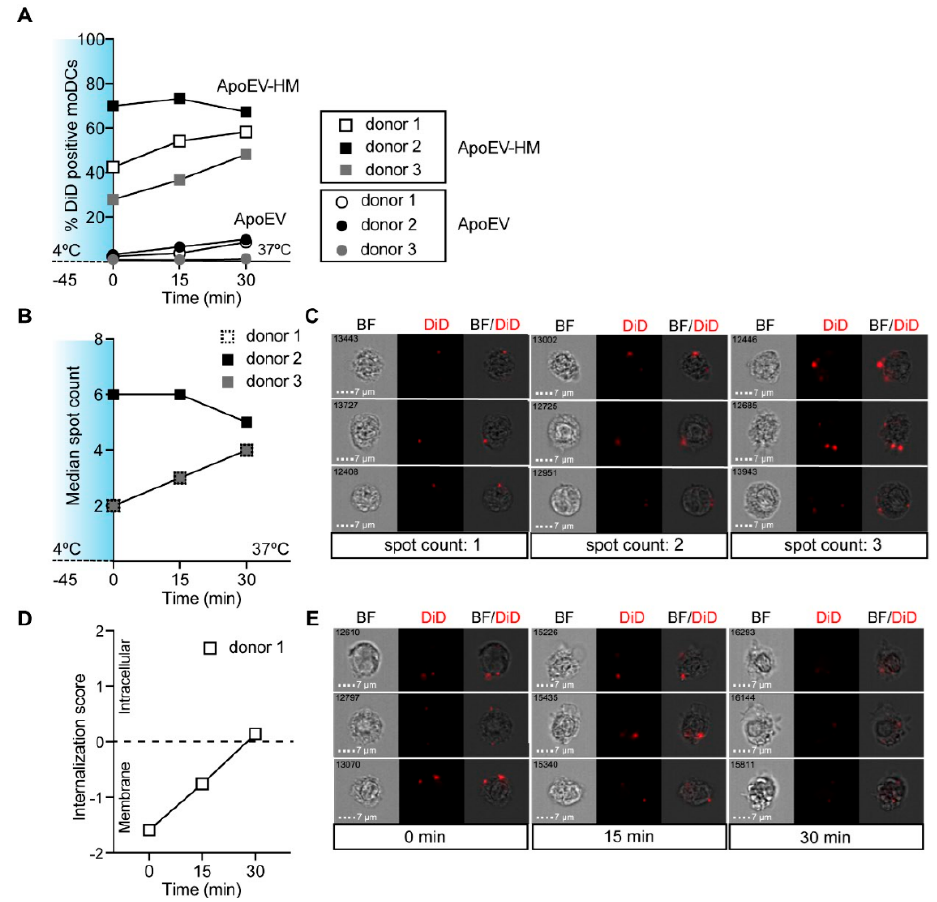
Figure 3. Glycan modified ApoEVs (ApoEVs-HM) are internalized by moDCs. ( A ) MoDCs (white = donor 1, black = donor 2, grey = donor 3) were loaded with DiD-labeled ApoEVs and ApoEVs-HM for 45 min at 4 °C, washed, and incubated at 37 °C for the indicated times. MoDCs were analyzed using imaging flow cytometry. ( B ) Time course of the median spot count in the DiD-positive ApoEV-HM-loaded moDC population using imaging flow cytometry. ( C ) Representative pictures of ApoEV-HM-loaded moDCs at time point 0 min with 1, 2, or 3 positive spots. ( D ) Time course of the internalization score of ApoEVs-HM of donor 1. ( E ) Representative imaging flow cytometry pictures after 0, 15, and 30 min incubation at 37 °C of moDCs (donor 1) that are positive for 2 spots.